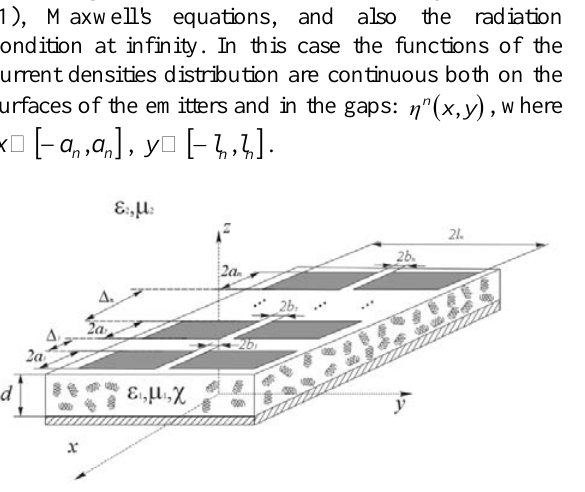
Fig. 1. Multi-element strip antenna